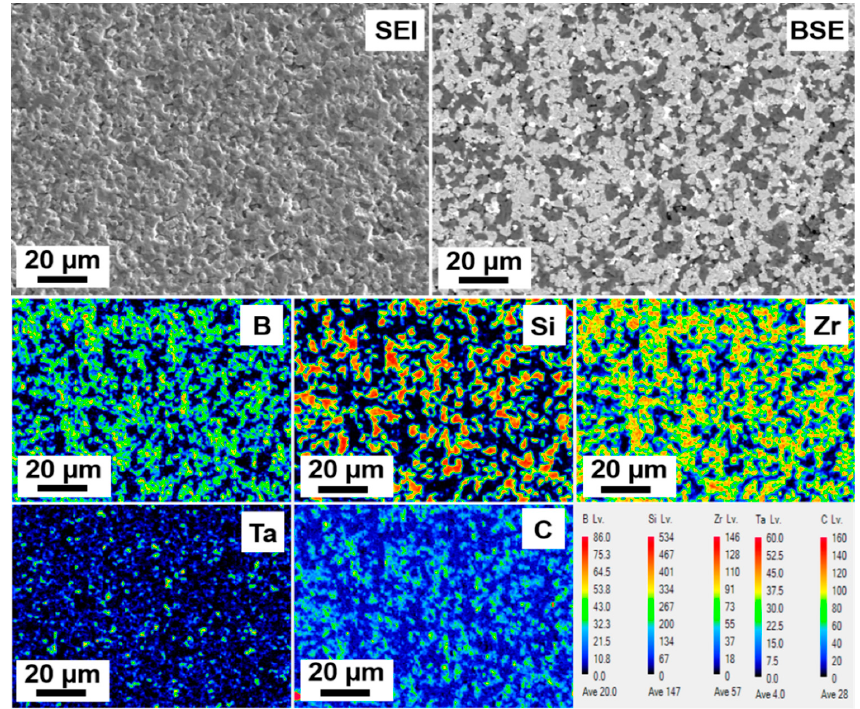
Figure 9. Field-emission-electron probe microanalysis (FE-EPMA) of ZrB 2 –SiC–TaC and its constituent compounds.